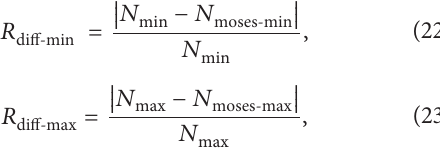
Table 9: Statistics for EC-Corpus testing